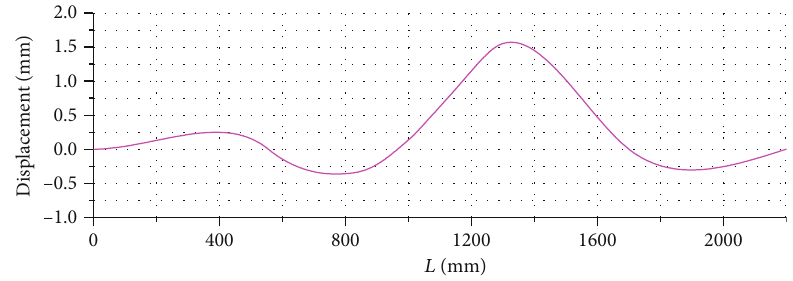
Figure 8: Displacement diagram when the gross load is